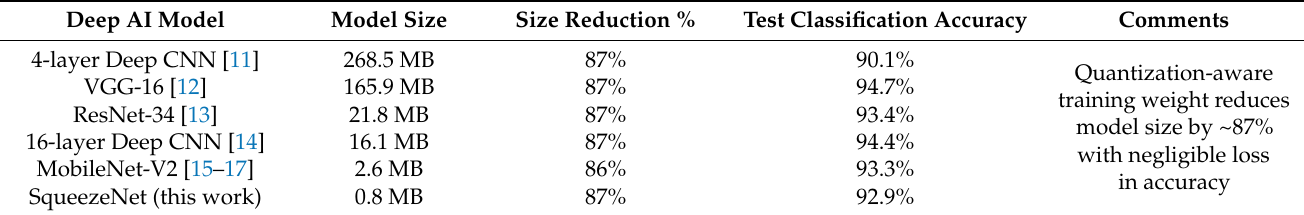
Table 7. Size and accuracy comparison of potential deep AI models with quantization-aware